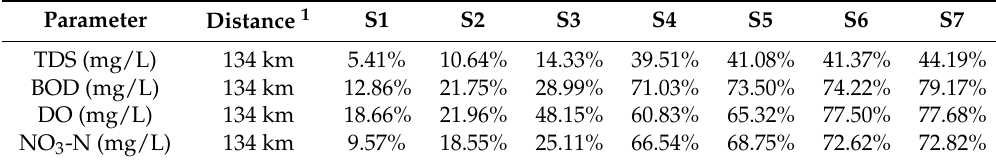
Table 6. Potential improvement in the river water quality for management scenarios (S1–S7). Parameter Distance 1